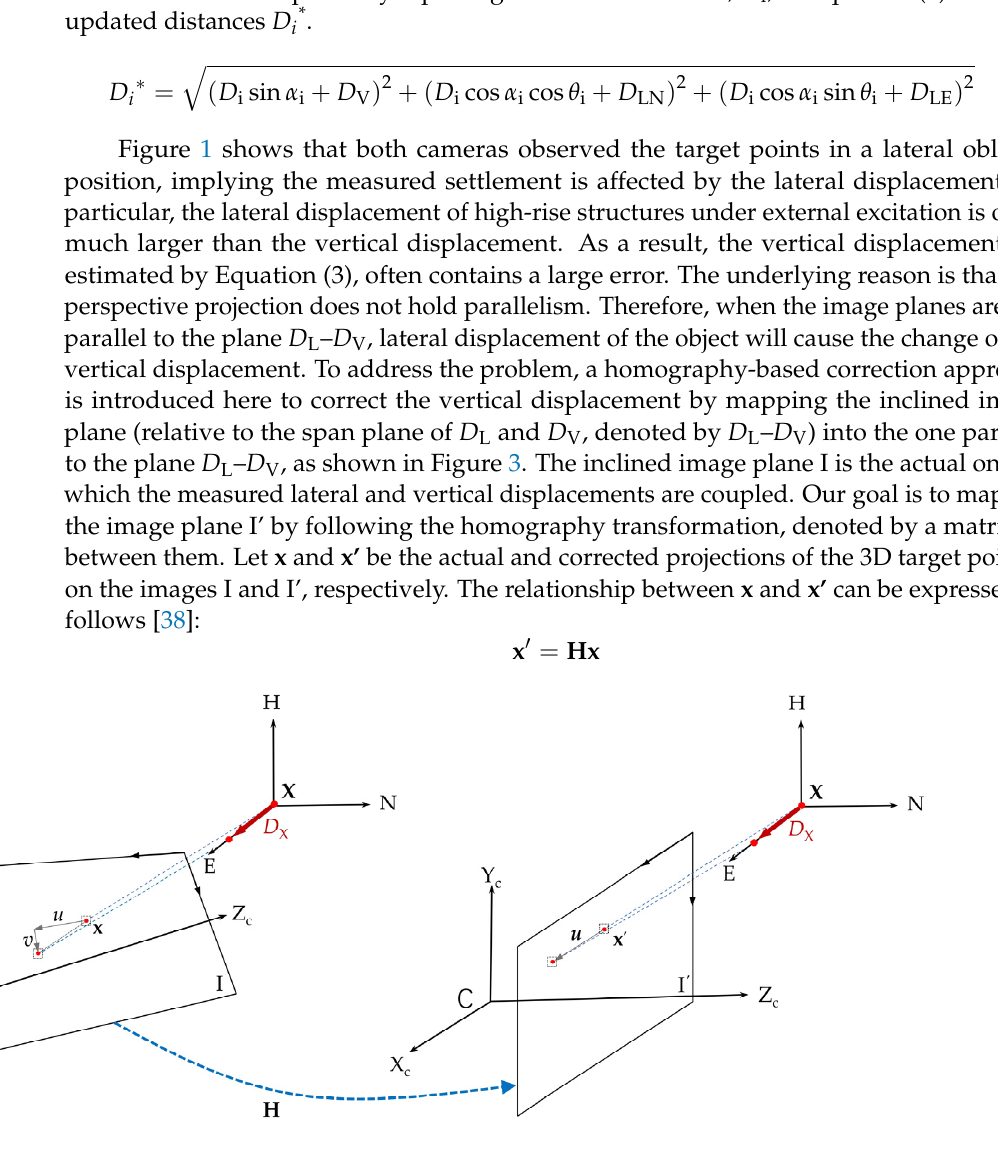
Figure 3. Homography-based vertical displacement correction.